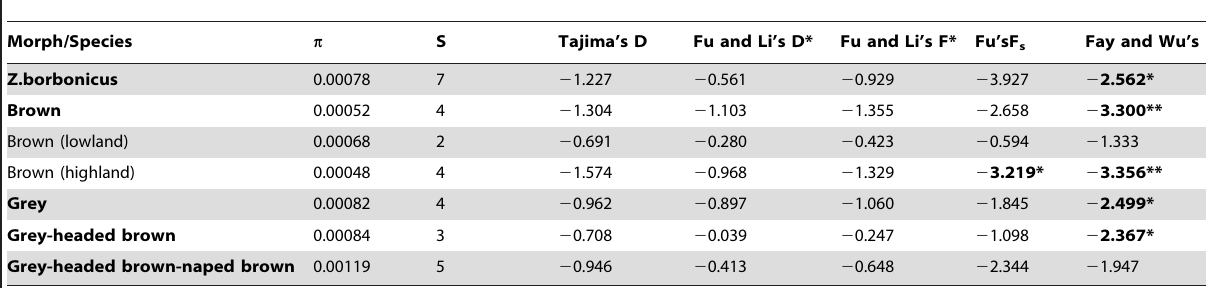
Table 5. Diversity statistics and results from selection tests for Z. borbonicus